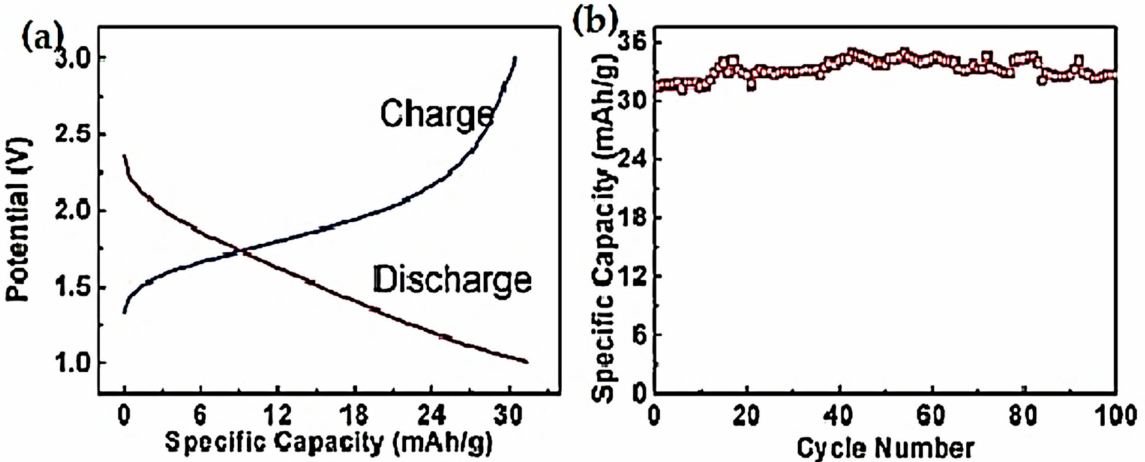
Figure 11. ( a ) Initial charge–discharge profile. ( b ) The corresponding cycle performance of TiO 2 nanorods as anode of LIBs. Reprinted with permission from Ref. [73]. Copyright 2014 ACS